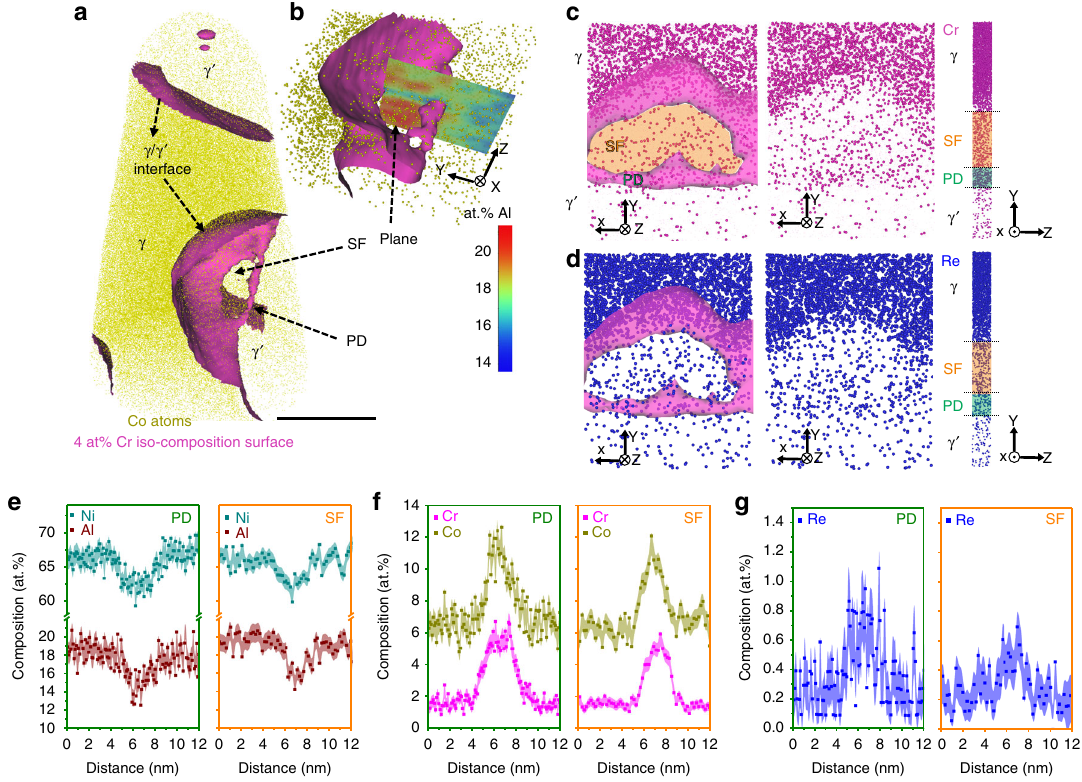
Fig. 4 APT analysis for 5% creep specimen. a APT reconstruction showing two γ / γ ′ interfaces and a SF in the γ ‘ precipitate. The SF is connected with a PD. b A close-up of the fault region, highlighting with a 2D projection, showing depletion of Al in the fault region. c Top (viewed along Z -axis) and side view (viewed along X -axis) showing the distribution of Cr atoms from γ / γ ′ interface to SF and PD. d Top (viewed along Z -axis) and side view (viewed along X - axis) showing the distribution of Re atoms from γ / γ ′ interface to SF and PD. 1D compositional pro fi le along Z showing the distribution of the elements perpendicular to PD (green rectangle) and perpendicular to SF plane (orange rectangle): e Ni and Al; f Cr and Co; g Re. Scale bar in ( a ): 20 nm. The error bars in ( e – g ) are estimated as described in Methods